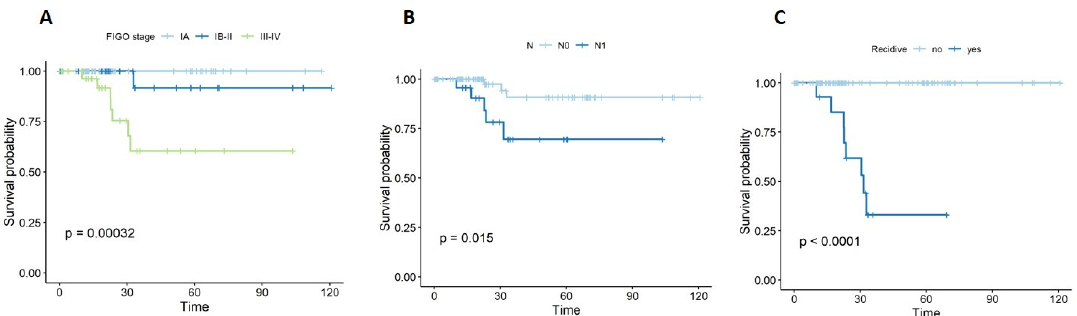
Figure 2. Kaplan–Meier curves for OS with respect to ( A ) stage, ( B ) lymph node metastasis, and ( C ) recurrence.